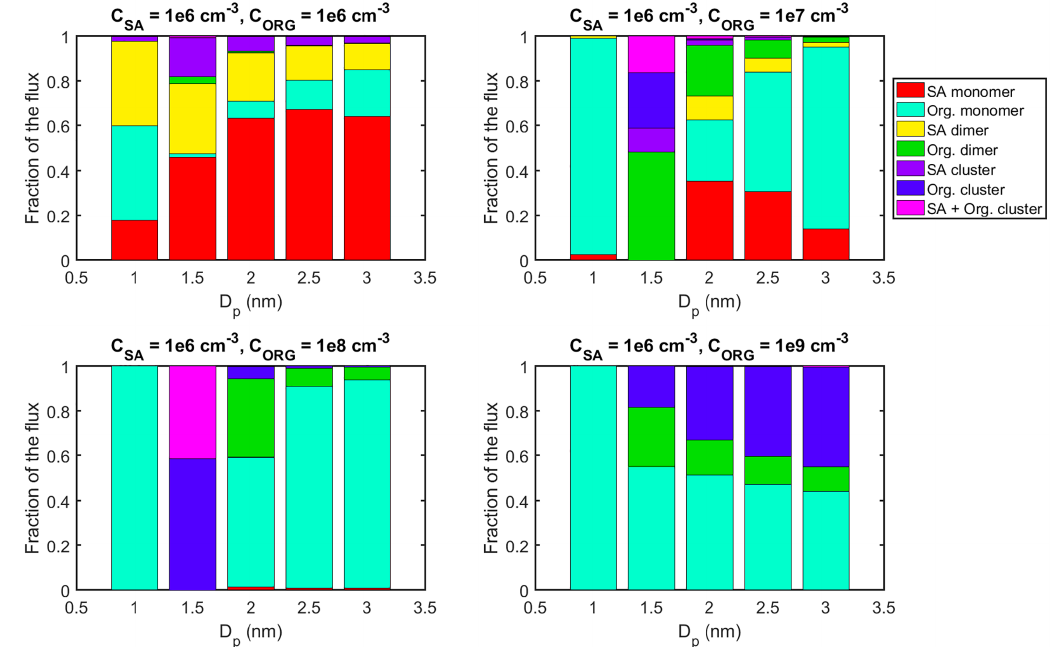
Figure A3. Contribution of different vapor monomers and clusters to the net flux past different threshold sizes in simulations with SA–NH 3